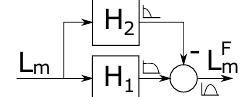
Figure 6. Line data filtering with two low-pass